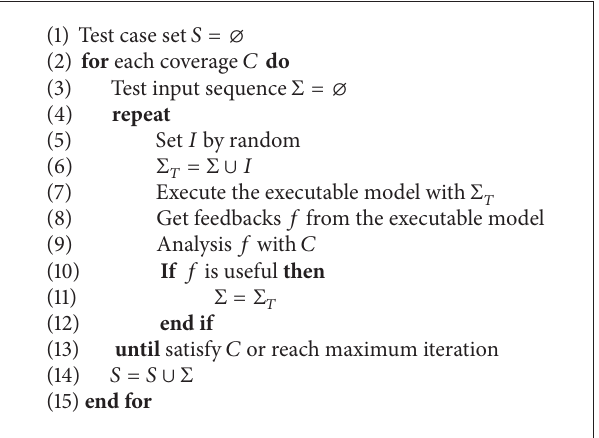
Algorithm 1: Pseudocode of random